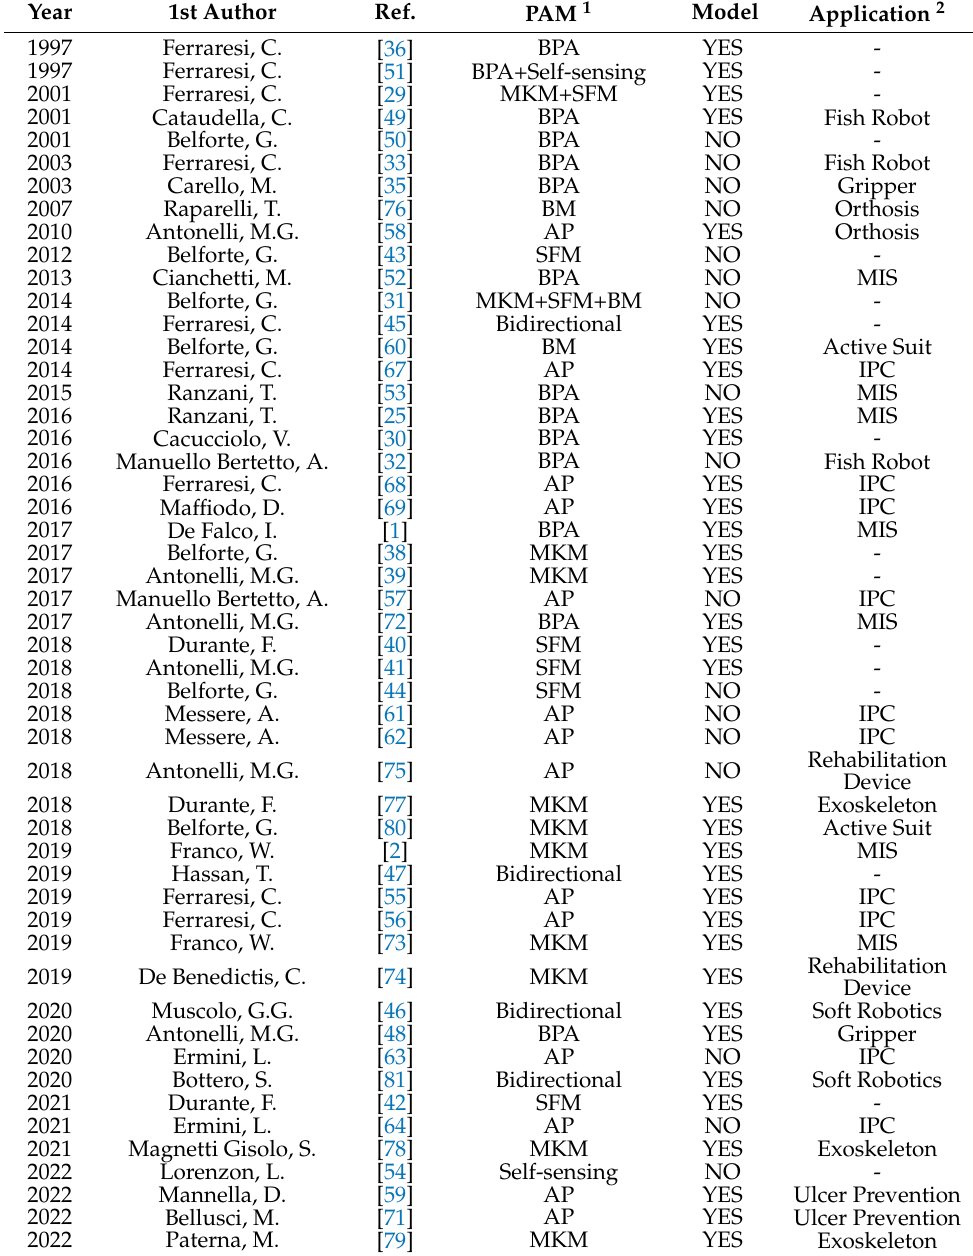
Table A1. Classification table of the 51 papers from Italian researchers reviewed. For each paper, year of publication, first author, and reference number are given. Furthermore, the type of PAM, the presence of an analytical/numerical model, and application (if available) are